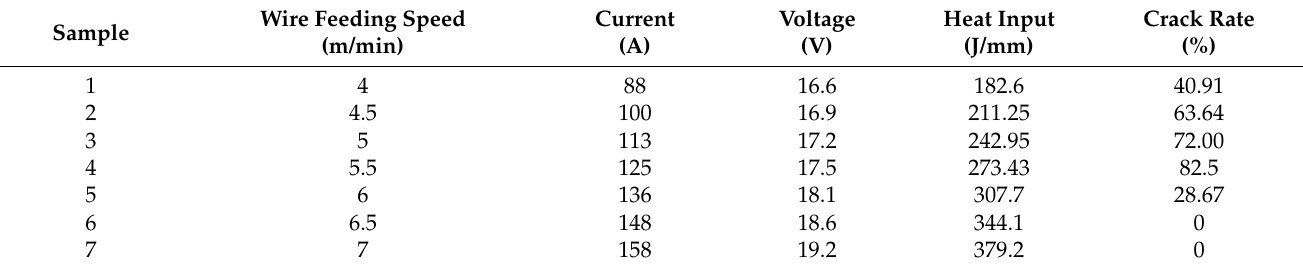
Table 4. Process parameters and the crack rate of CMT welding processing.